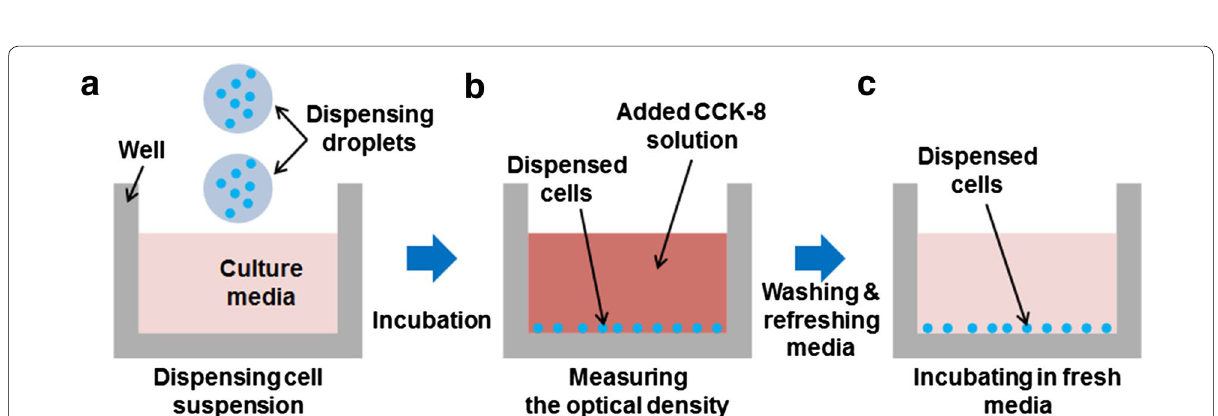
Fig. 3 Schematic views of the cell proliferation test procedure: a dispensing of cell droplets into the well, b addition of the CCK-8 solution into the well and measurement of light absorbance after incubation, and c replacement with fresh cell